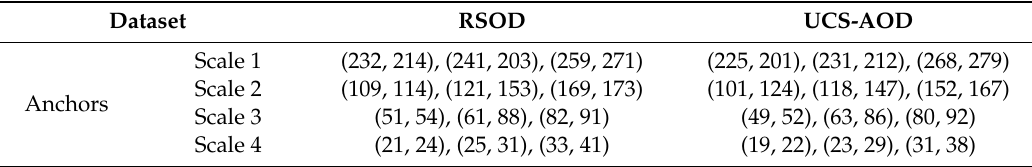
Table 5. The corresponding anchor boxes for the RSOD and UCS-AOD datasets.